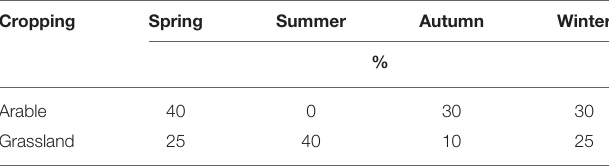
TABLE 1 | Seasonal distribution of livestock slurry applications by type and land use.